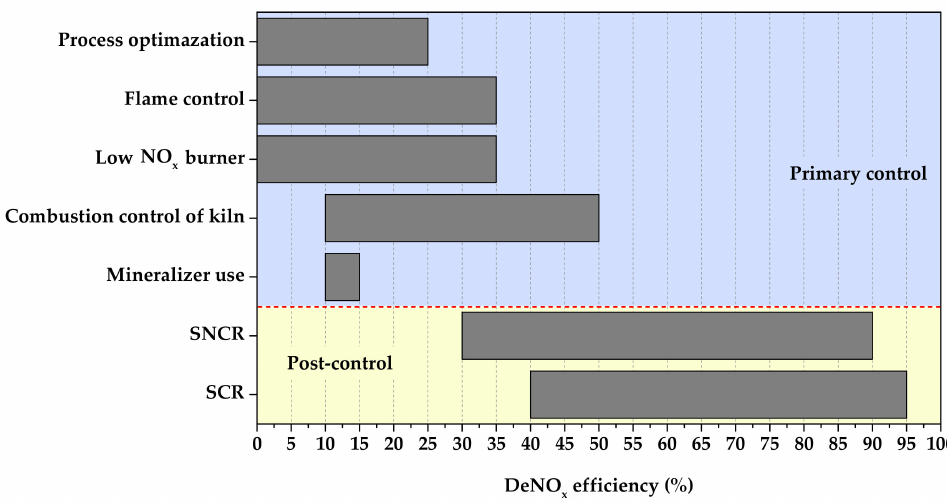
Figure 8. DeNO x solutions in cement production (data taken from [22]).